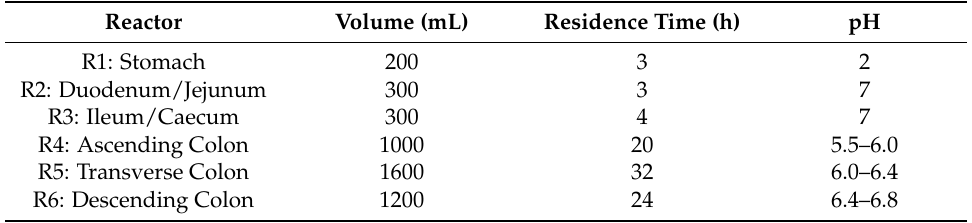
Table 1. Set-up of the SHIME ® , with reactor volumes, residence times and pH values (based on